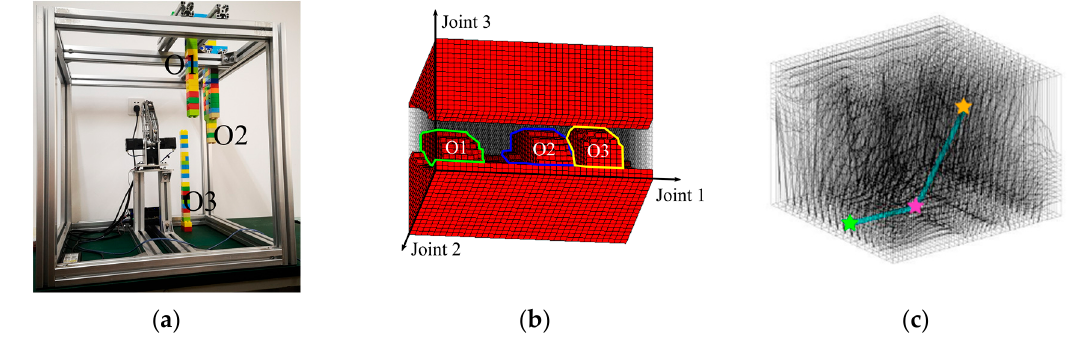
Figure 19. The setup of the second experimental environment. ( a ) The setup of the environment. ( b ) The configuration space of the second environment. ( c ) The distorted configuration space. The start point is colored by green, and the target point is colored by yellow. One passing point is colored by purple.